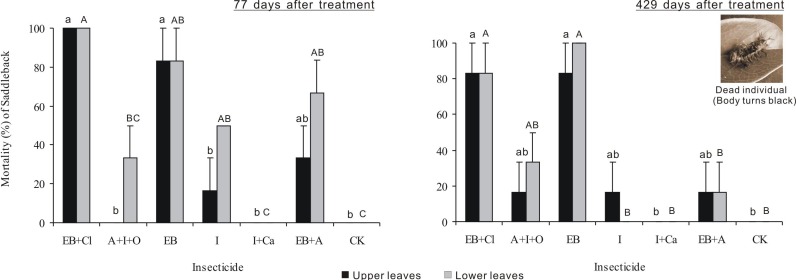
Larval mortality.Mean (±SE) mortality of Latoia lepida larvae on upper and lower leaves collected from Osmamthus fragrans trees treated with the insecticides of EB + CL, A + I + O, EB, I, I + Ca, and EB + A, by trunk injection after 77 and 429 days, respectively. N = 42 isolated branches in each observation time. Any observation time, insecticides effect was significant (P < 0.001); leaf position and insecticides × leaf position interaction effects were not significant. Bars labeled with different lowercase or uppercase letters are significantly different at P = 0.05 from each other in the same leaf layer group (upper or lower leaves) based on Dunn’s range test.